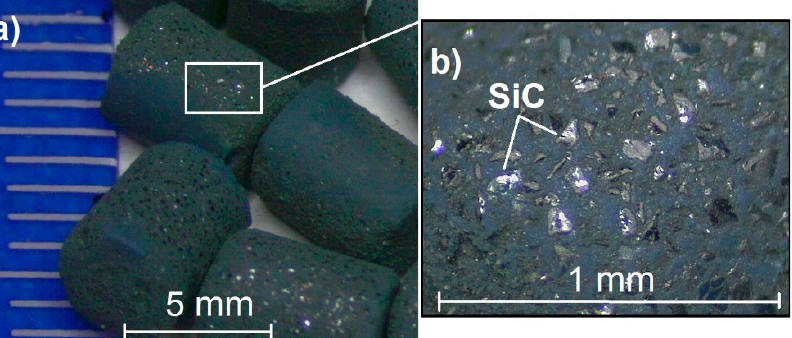
Figure 19. Abrasives for roughing. ( a ) an overview of the material, ( b ) the SiC particles anchored in plastic cylinders.